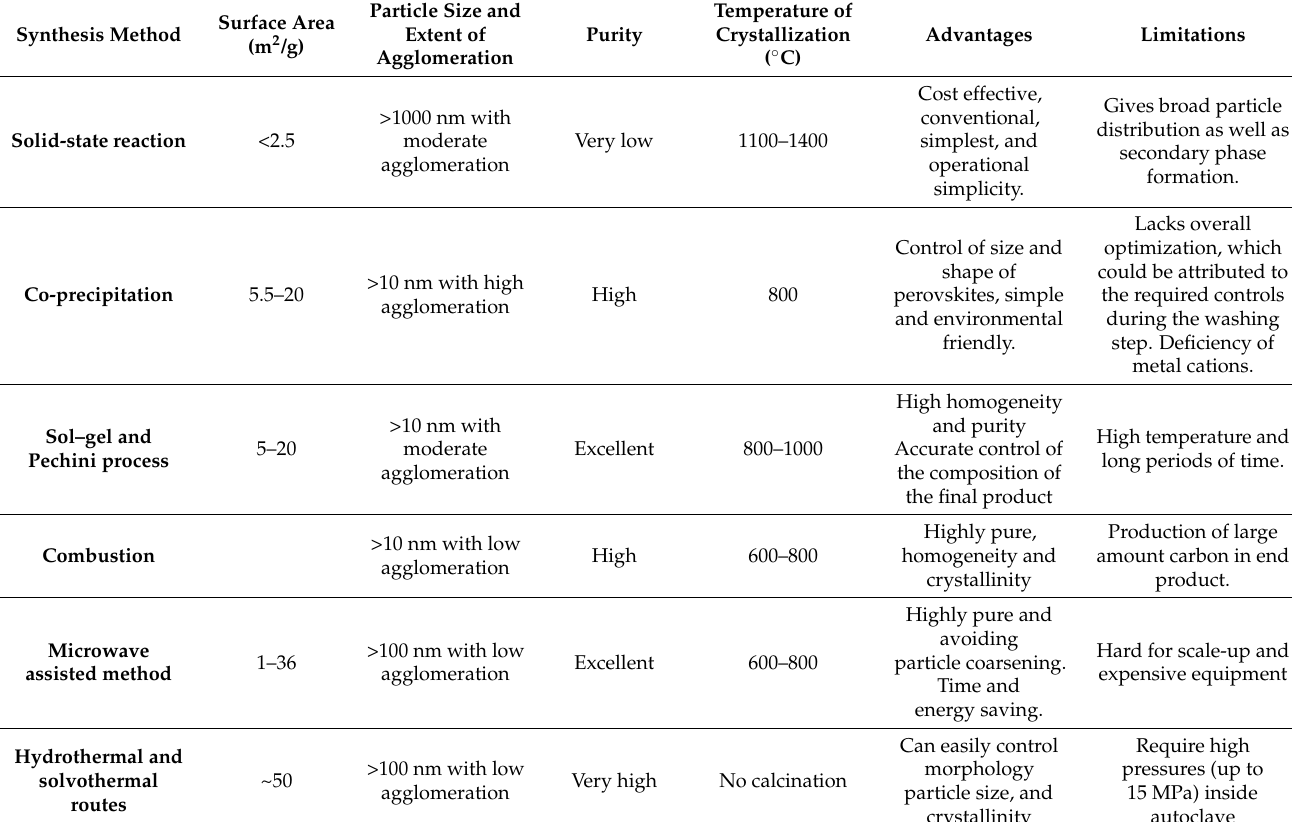
Table 2. Characteristics of methods for perovskites synthesis (adapted from